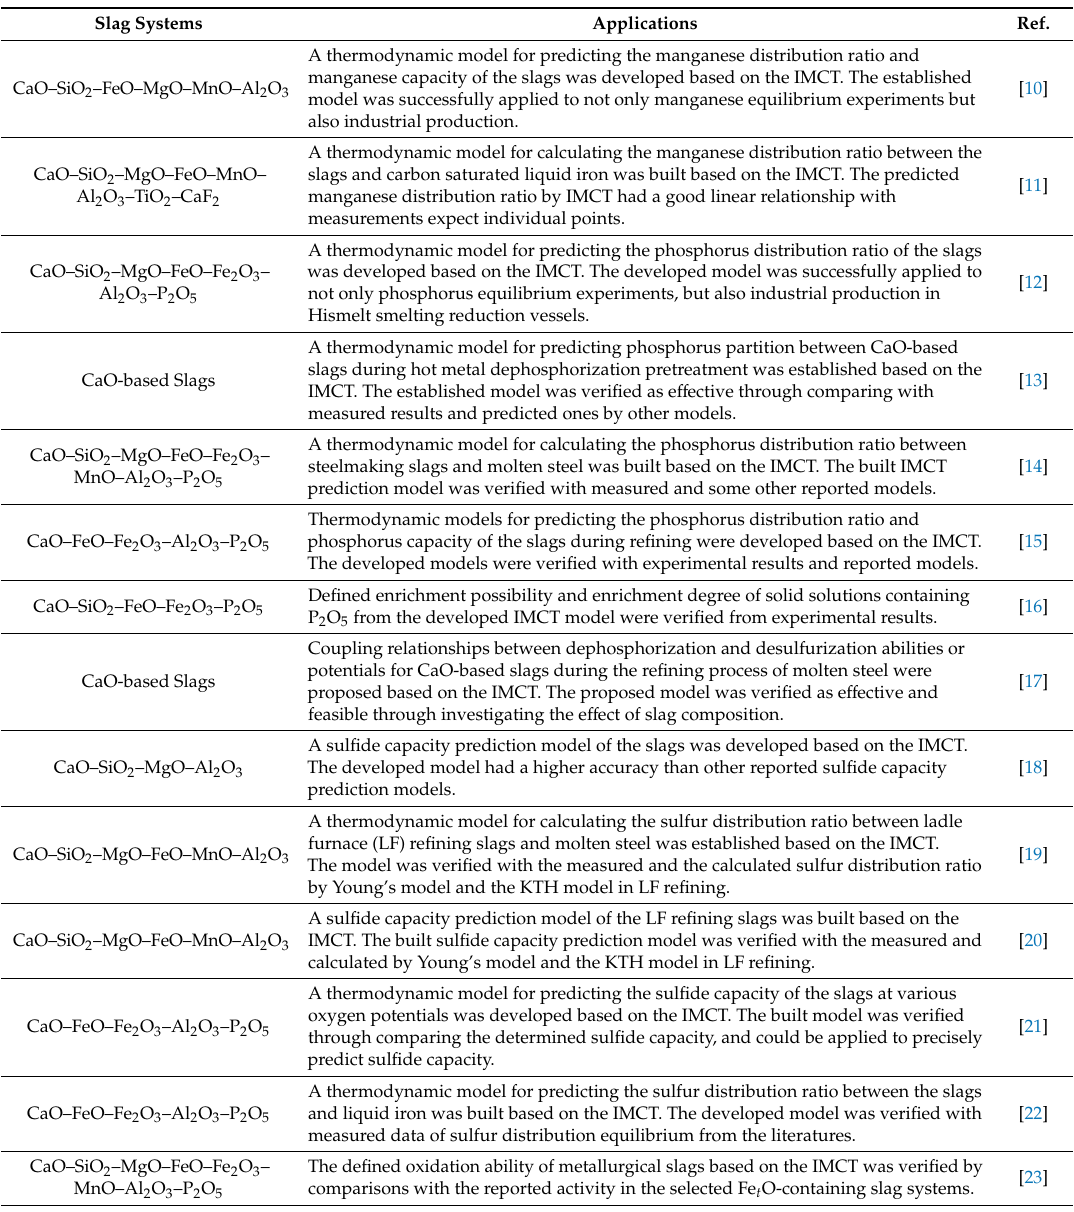
Table 1. Applications of the ion–molecule coexistence theory (IMCT) model during ironmaking and steelmaking